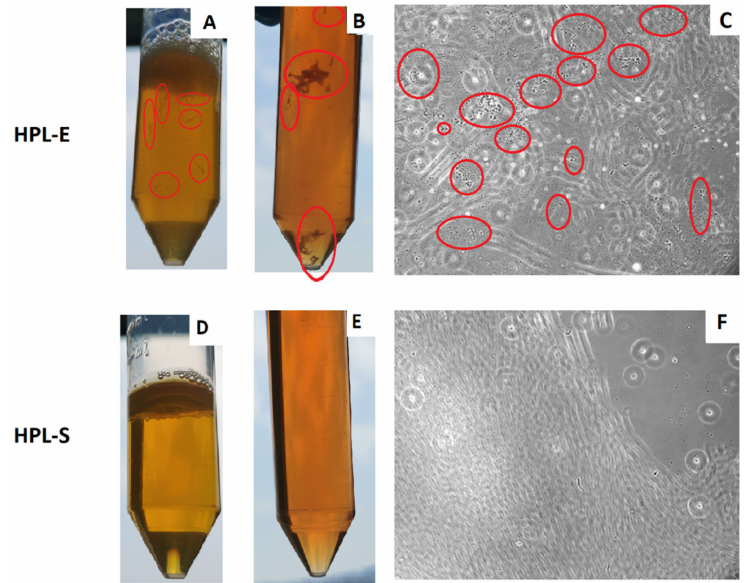
Figure 1. Pictures of HPL-E ( A ) or HPL-S ( D ) after thawing and of the medium Alpha MEM with HPL-E ( B ) or HPL-S ( E ) two days after the preparation and filtration, and representative microscopic observations of the MSCs in the BM-MSCs in HPL-E ( C ) and in HPL-S ( F ) during the culture (Magnification 10 × ), focusing on the debris. Red circles are placed on evidence of platelet aggregates and debris present only in the HPLE condition.